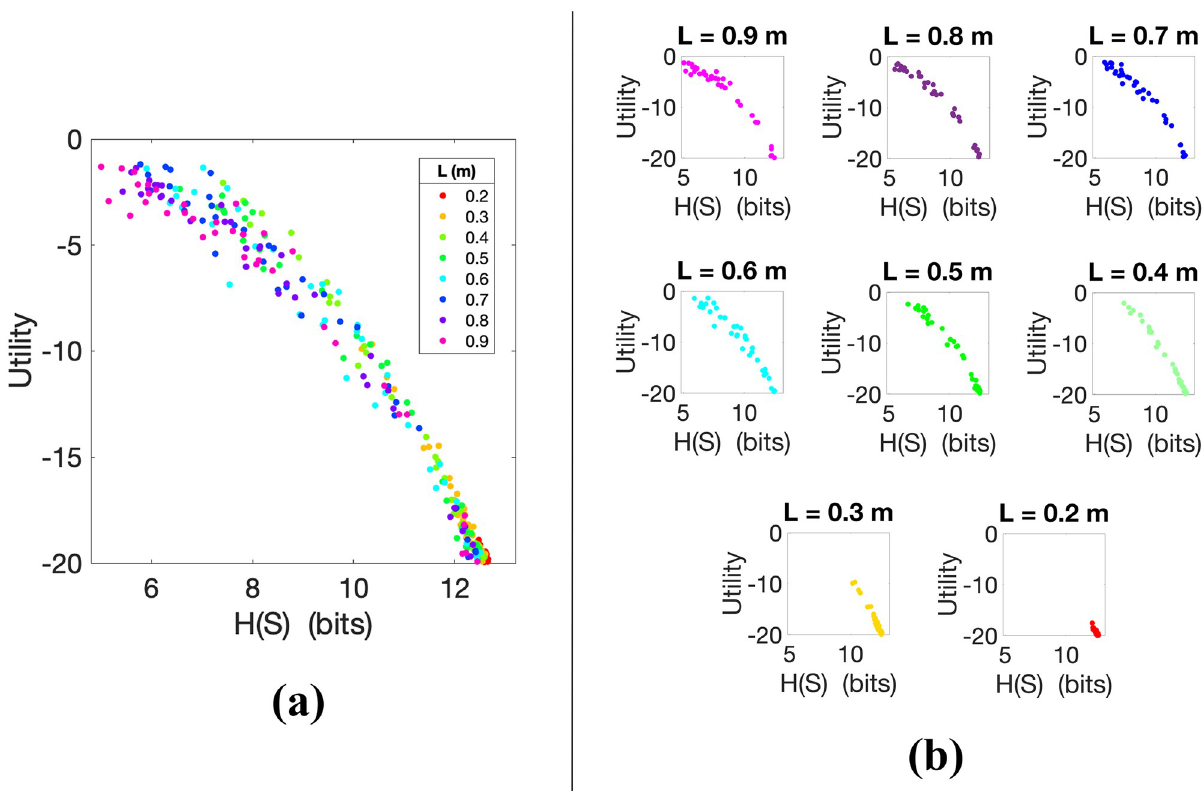
Fig 4. (a) Utility U i of trials i during the balancing task plotted as a function of H ( S i ) for all participants and pendulum lengths L . Spearman correlation ρ = − 0.982. In (b) the trials are separated by pendulum length in different subplots.